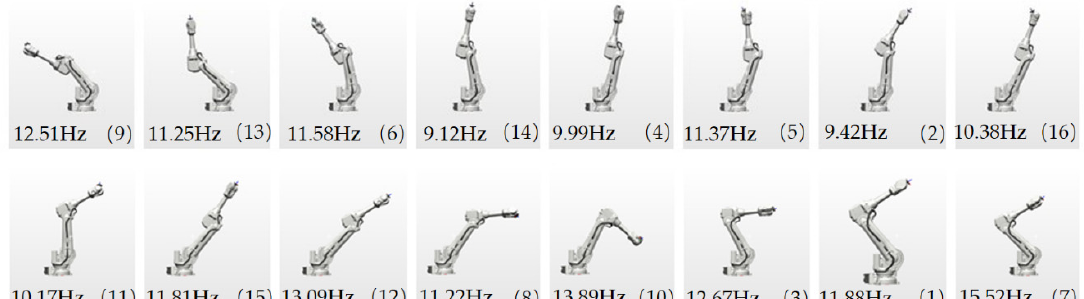
Figure 7. Random configurations for model verification.